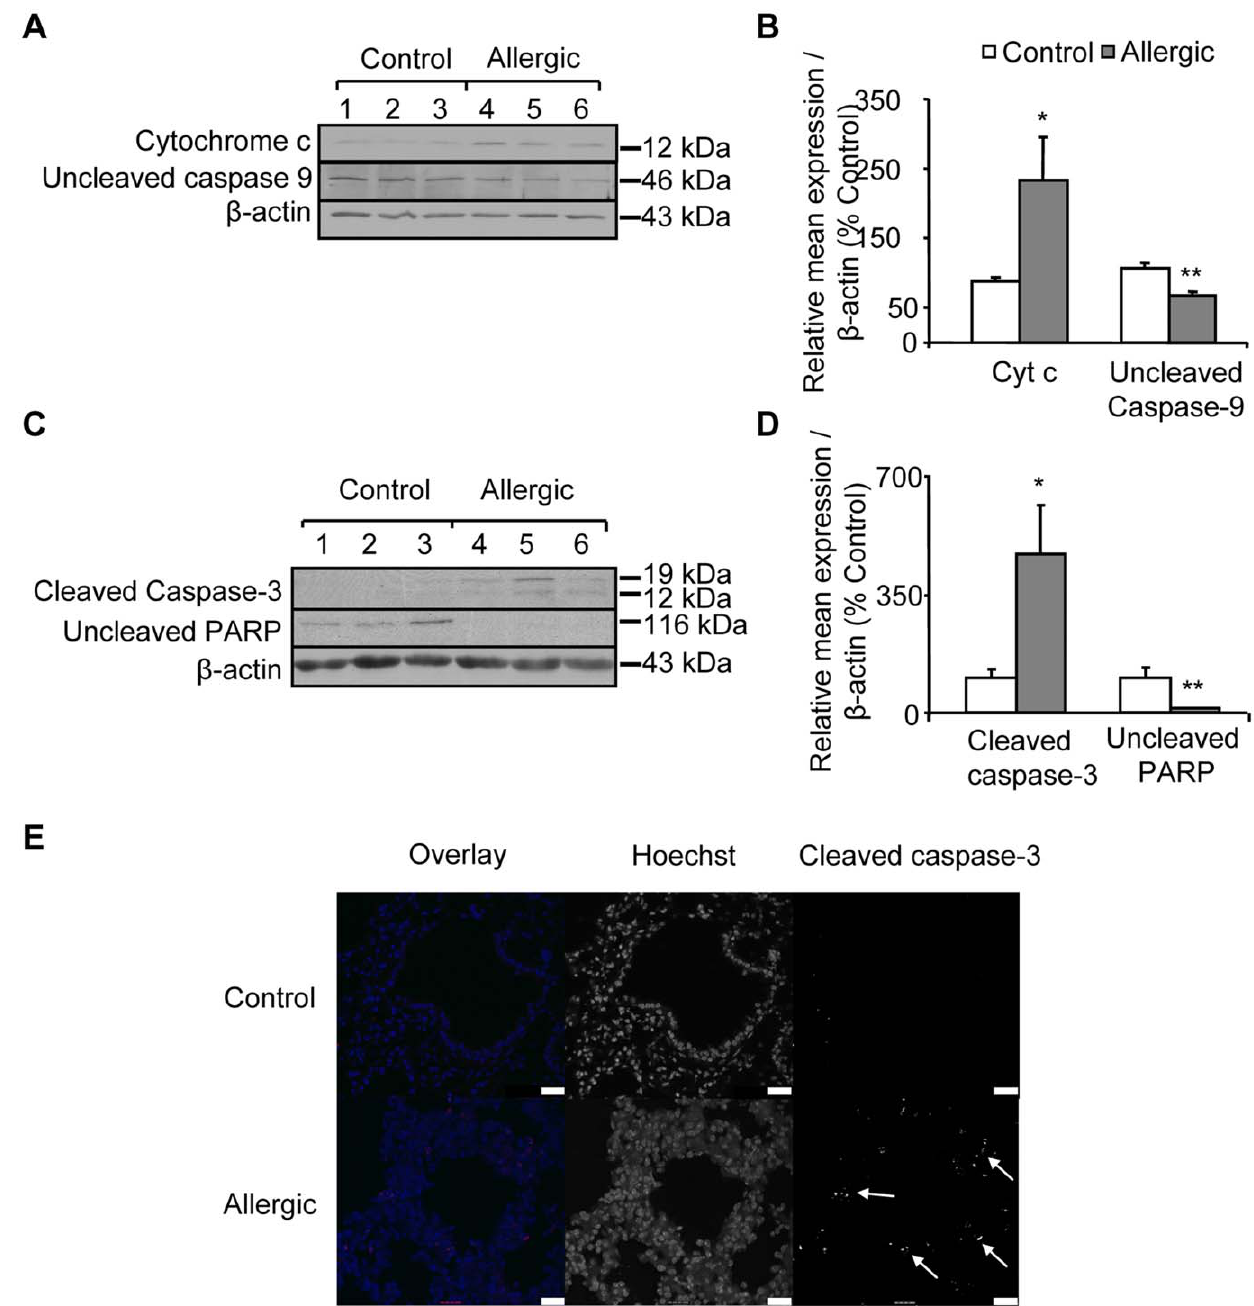
Figure 6. Allergic airway inflammation increases pro-apoptotic signalling from mitochondria. Cytosol from control and allergic mice were isolated during the subcellular fractionation procedure as described in Methods section. (A) Expression of the uncleaved caspase-9 and cytochrome c were studied by Western blot in the cytosol. Representative Western blots are shown. (B) Quantitation of band intensity by densitometry from blots after normalization against actin is shown. (C) Expression of the PARP and cleaved caspase-3 were studied by Western blot in total lung homogenate. Representative Western blots are shown. (D) Quantitation of band intensity by densitometry from blots after normalization against actin is shown. (E) Hoechst and anti-cleaved caspase-3 (red) staining in representative confocal images from control and allergic mice lung sections. White arrow heads points to cleaved caspase-3 shown as red pixels in overlaid cleaved caspased-3-Hoechst images and as white pixels in cleaved caspase-3 grey scale images. Scale bars, 25 m m. Results are presented as means 6 SEM; * p , 0.05; ** p , 0.001 from control. doi:10.1371/journal.pone.0039183.g006 certain human bronchial epithelial cell lines express both mtER a and mtER b [45].